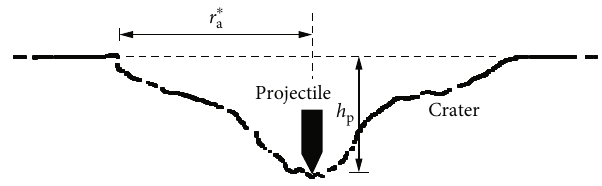
Figure 3: Diagram of the crater of the hypervelocity impact.